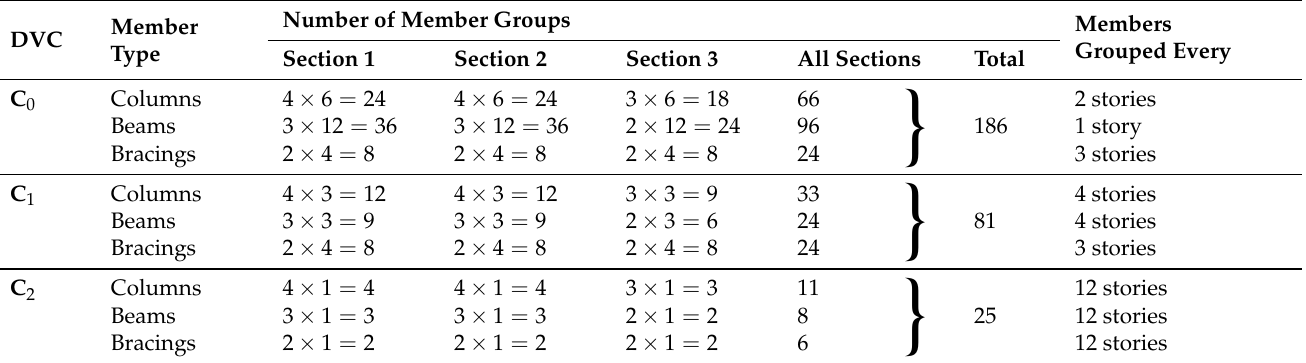
Table 2. Test Problem 2 (36-story steel space frame): number of design variables (total and per section of the structure) and their allocation to the structural parts for each of the 3 design variable configurations